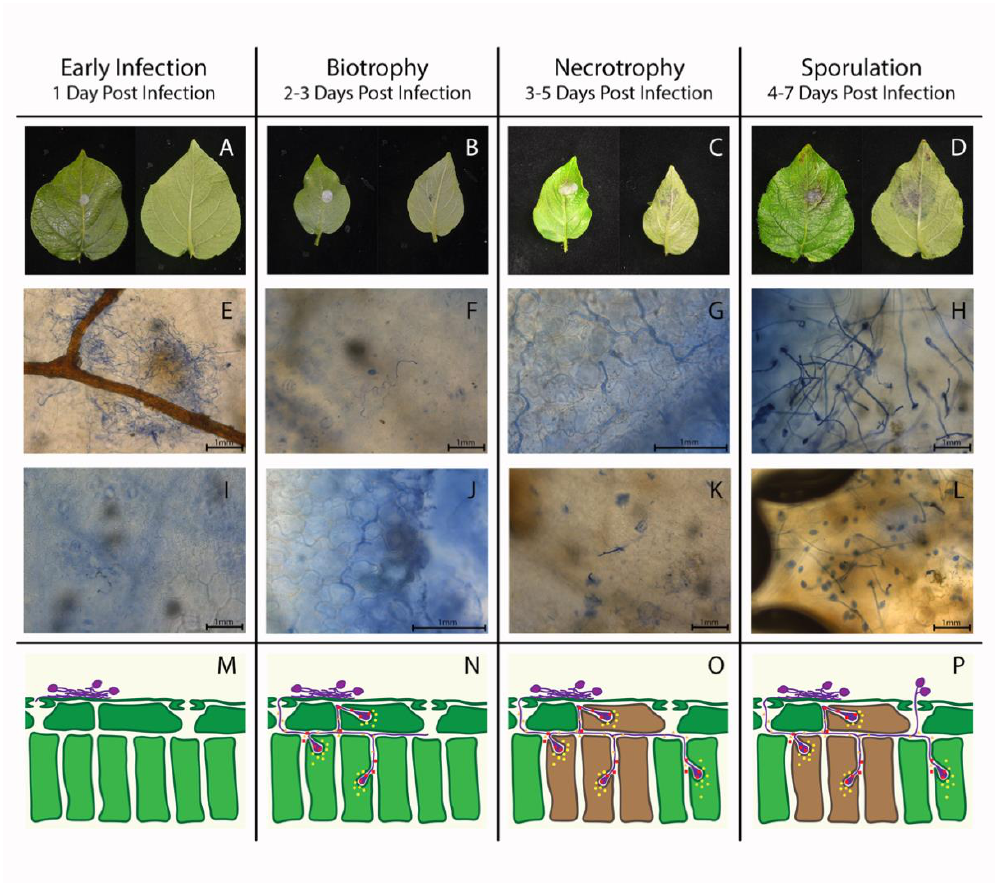
Figure 1. Representative potato leaves during late blight ( A ) early infection, ( B ) biotrophy , ( C ) necrotrophy , and ( D ) sporulation. Phytophthora infestans infection progression illustrated by ( E – L ) microscopy with enhancement by tryphan blue staining, and by a computer-stylized cross-section of ( M ) early infection, ( N ) biotrophy, ( O ) necrotrophy, and ( P ) sporulation. Progress of tissue infection is consistent with increasing necrosis and pathogen